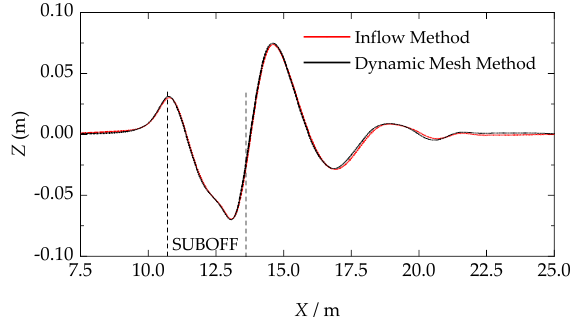
Figure 7. Wave profile on the free surface.